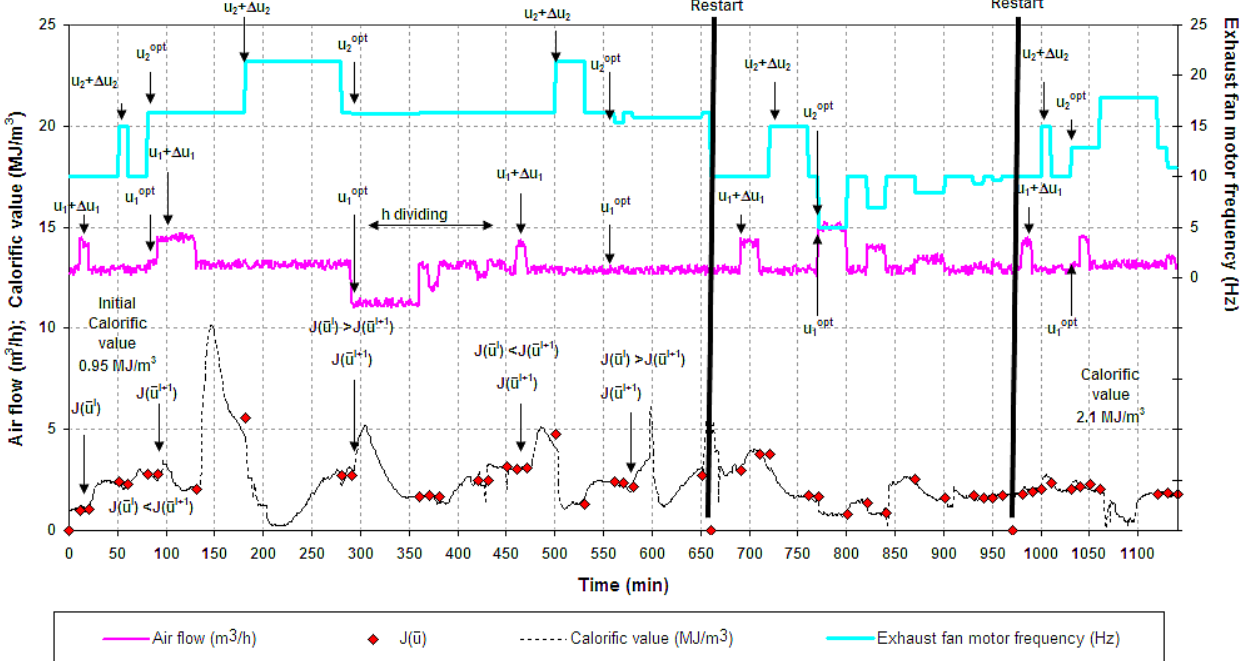
Figure 10. The second test of optimal control with optimization of two parameters.